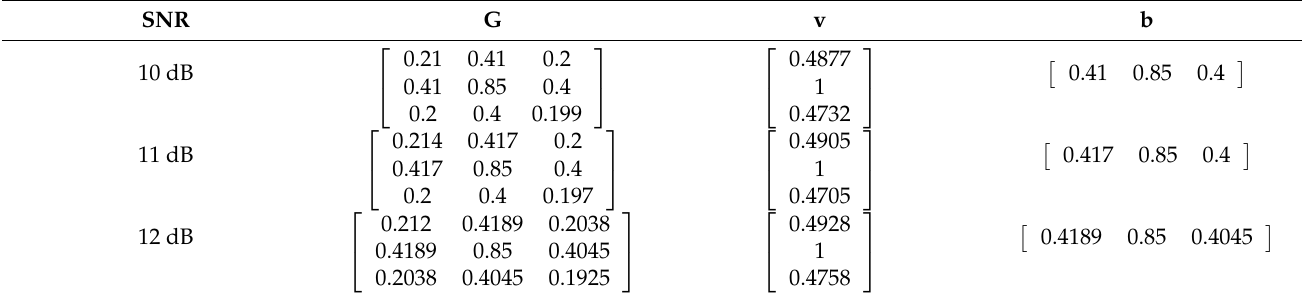
Table 2. Parameters of the target v and b with 1.8 blur and 10% misalignment.